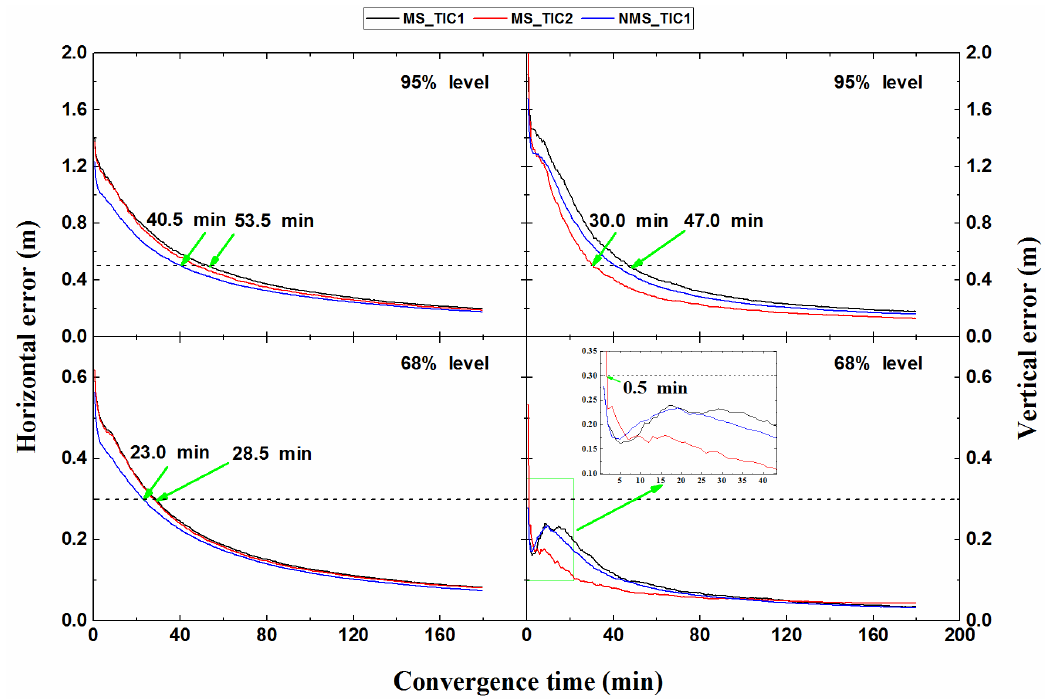
Figure 5. The GPS static SF PPP convergence performance in different constraint schemes during the MS and NMS periods.